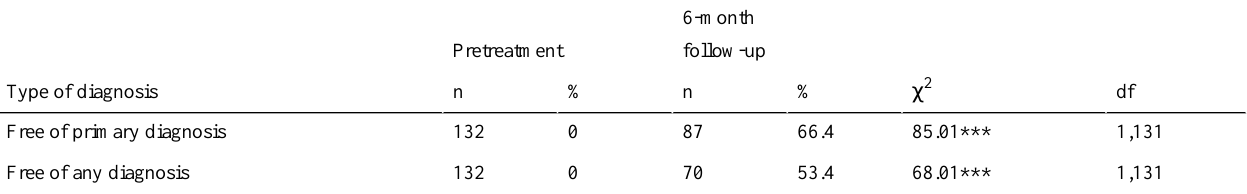
Table 2. Children and adolescents free of primary diagnosis and any diagnosis at pretreatment and 6-month follow-up.